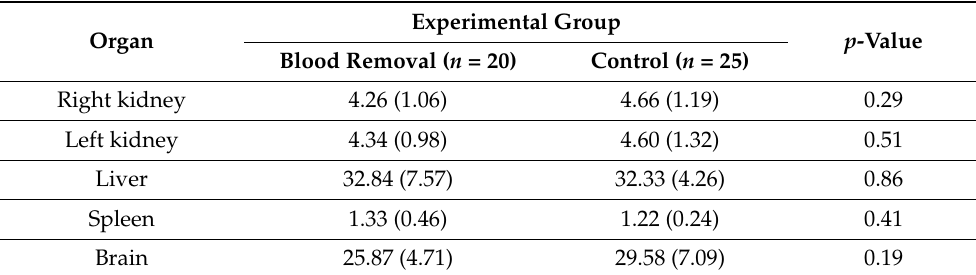
Table 9. Relative organ weights of piglets in Trial